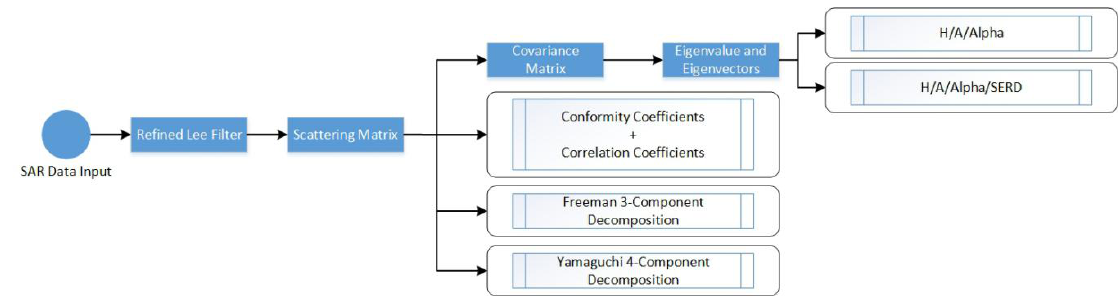
blocks constitute the decoder part, it outputs a classification map with the same size as original image.